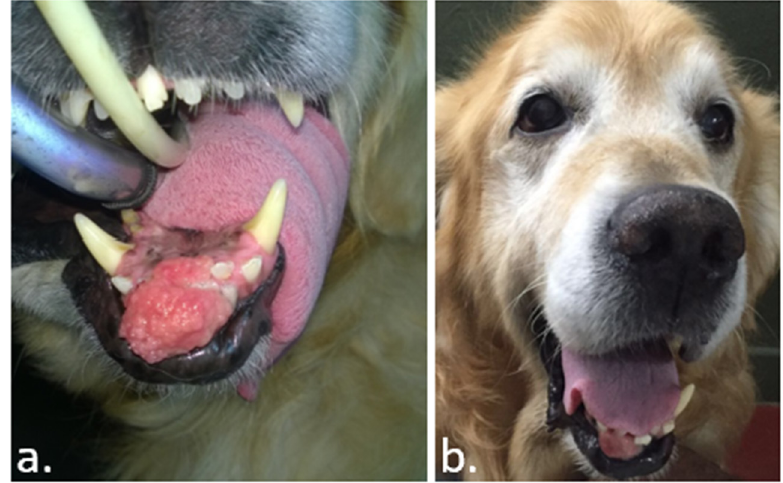
Figure 2. A case of a golden retriever with a fibrosarcoma, in ( a ), before the ECT. In ( b ), the patient obtained a partial response after the treatment. In contrast to the natural evolution of the disease, it remained stable without any other treatment after two years (data not published).